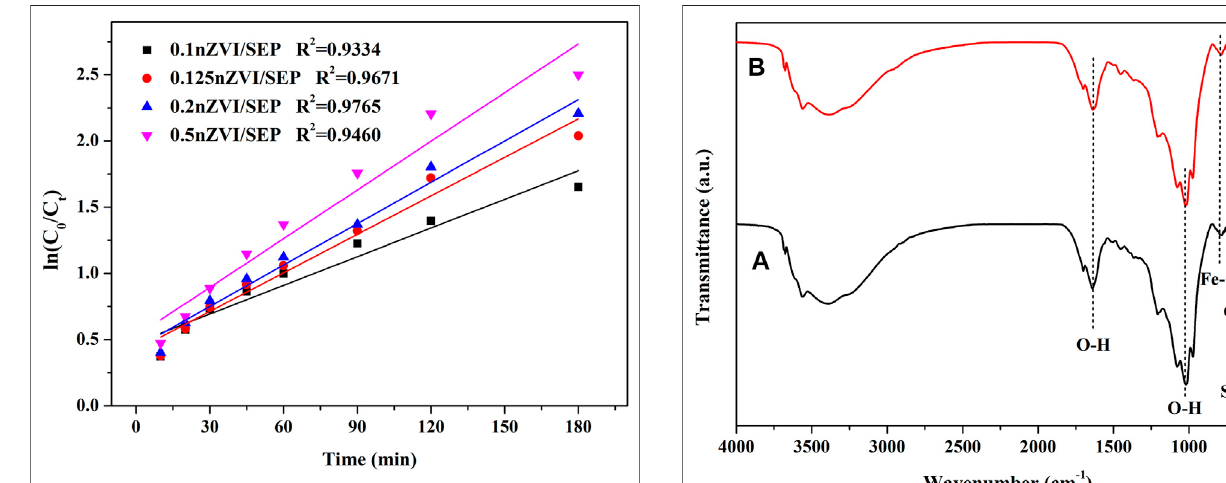
FIGURE 10 | FTIR spectra of 0.5nZVI/SEP sample (A) before and (B) after the reaction with